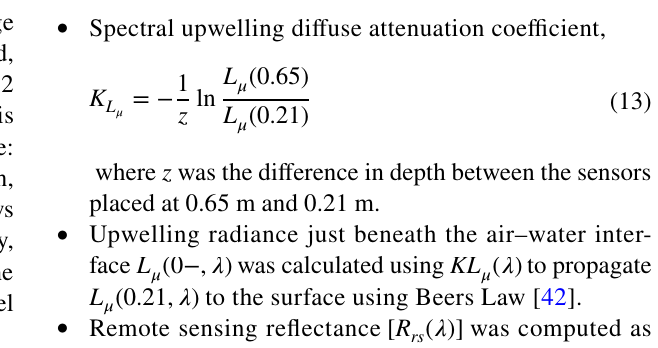
Fig. 3 WorldView2 mutlispectral images collected in Florida at a SJB b KB and c SGS. Labelled region colormap: seagrass → → blue, sand cyan, land yellow and intertidal model [41] classification results are shown in d SJB e KB and f